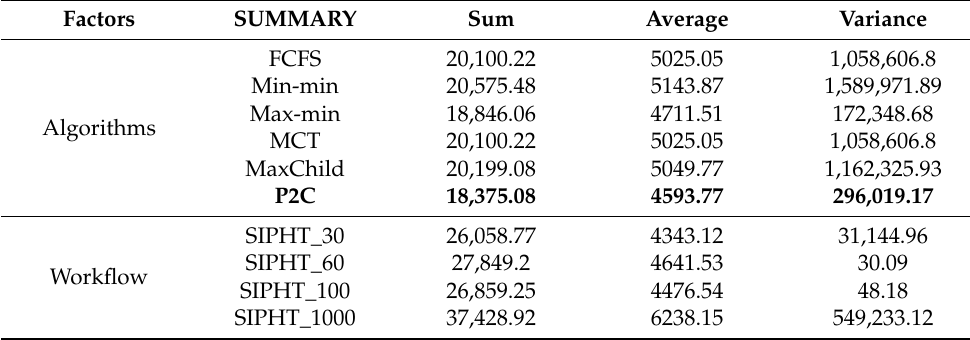
Table 14. Two way ANOVA summary results for SIPHT workflow. Factors